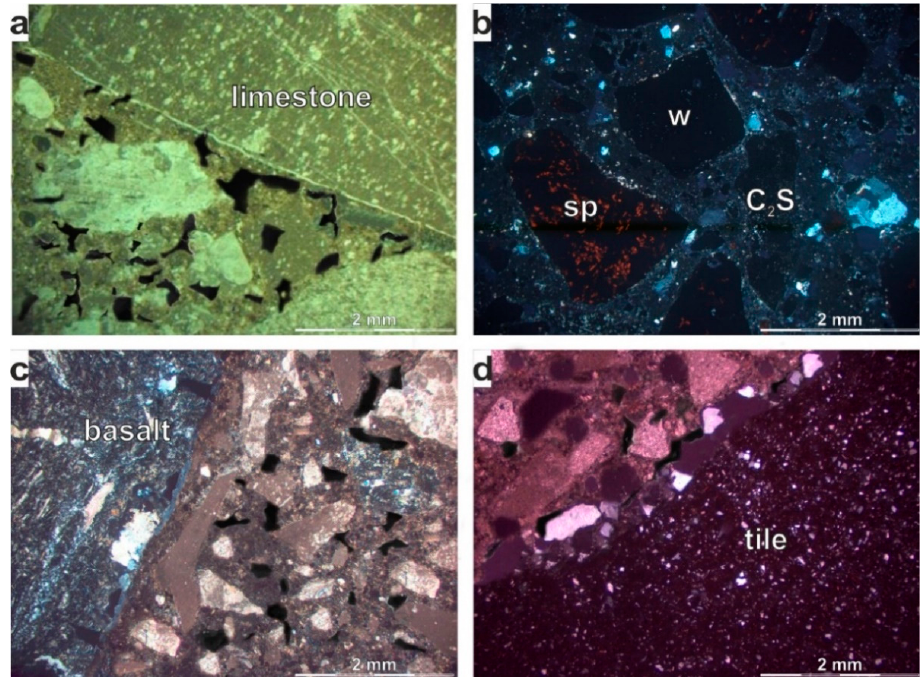
Figure 6. Photomicrographs of representative tested concrete specimens showing: ( a ) satisfactory cohesion between the limestone aggregate and the cement paste (sample S1B, XPL); ( b ) satisfactory cohesion between the basalt aggregate and the cement paste (sample S2B, XPL); ( c ) grains of slags containing calc ‐ silicate phase (C 2 S), spinel (sp), and wüstite (w), which have the worst bonding with the cement paste (sample S3B, XPL); ( d ) tile coating with quartz primer, which display the worst cohesion with the cement paste (sample S4B, XPL).